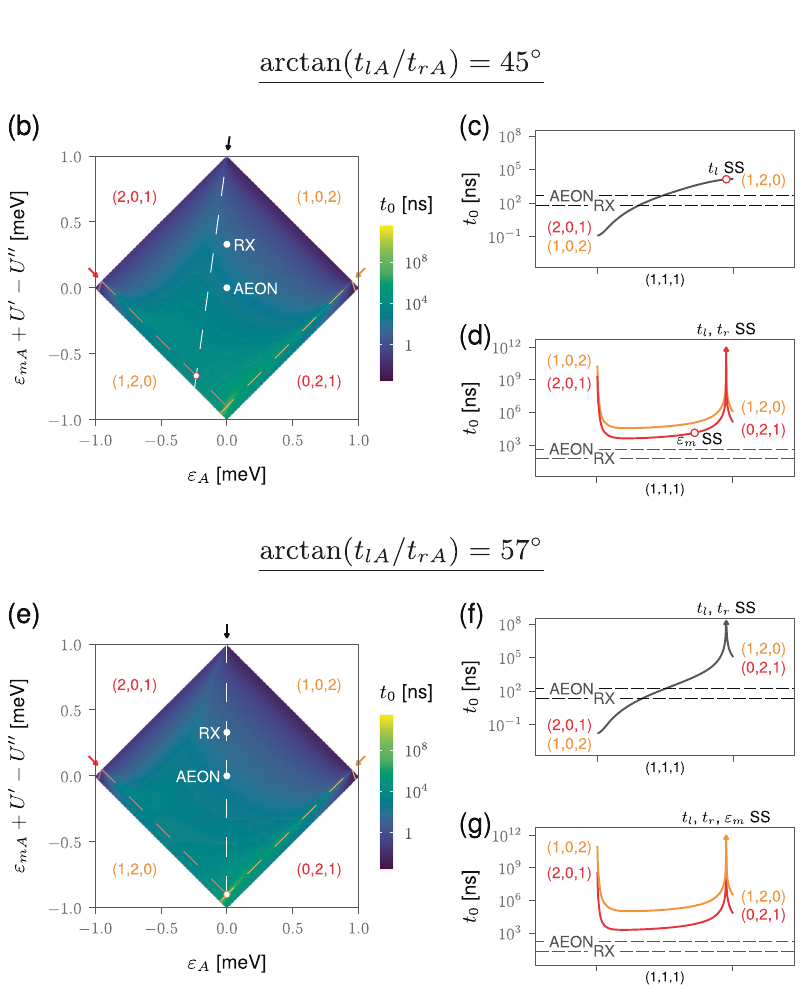
Fig. 2 Gate sequences and gate times in detuning space. a Exact gate sequences and timings for CPHASE (red dashed box) and CNOT (blue dashed box). Effective single-qubit Hamiltonians (Eqs. (2), (3)) generate unitaries for qubit A/B, U A = B ð x ; t Þ (cid:1) exp ð i ^ σ x g U A = B ð z ; t Þ (cid:1) exp ð i ^ σ z ω A = B t = 2 Þ . The non-local unitary is given by Eq. (11) without noise. The non-local gate time t 0 is identical for CPHASE and CNOT, where k is an odd positive integer (Eq. (10)). b Color plot of gate times for equal tunneling t lA = t rA , with two-qubit sweet spots (2QSS) indicated for ε mA (white), t lA (red), and t rA (orange) with dashed lines. c Linecuts of ε mA 2QSS. Fastest gate times are at the top corner and increase down the ε mA 2QSS line. Fastest ( k = 1) AEON and RX gate times are 450 and 64 ns, respectively. At the intersection with t lA 2QSS, gate time is 13.6 μ s. d Linecuts of t lA and t rA 2QSS. Gate times go to in fi nity at the point where the two tunneling 2QSS intersect. Panels ( e – g ) repeat panels ( b – d ), but with tunneling arctan ð t lA = t rA Þ ¼ 57 (cid:7) , chosen such that the ε m 2QSS is along ε A = 0, which is the 1QSS, and which the operating points of AEON and RX lie on. As before, gate times increase as ε mA decreases, and goes to in fi nity at the t lA , t rA double 2QSS.